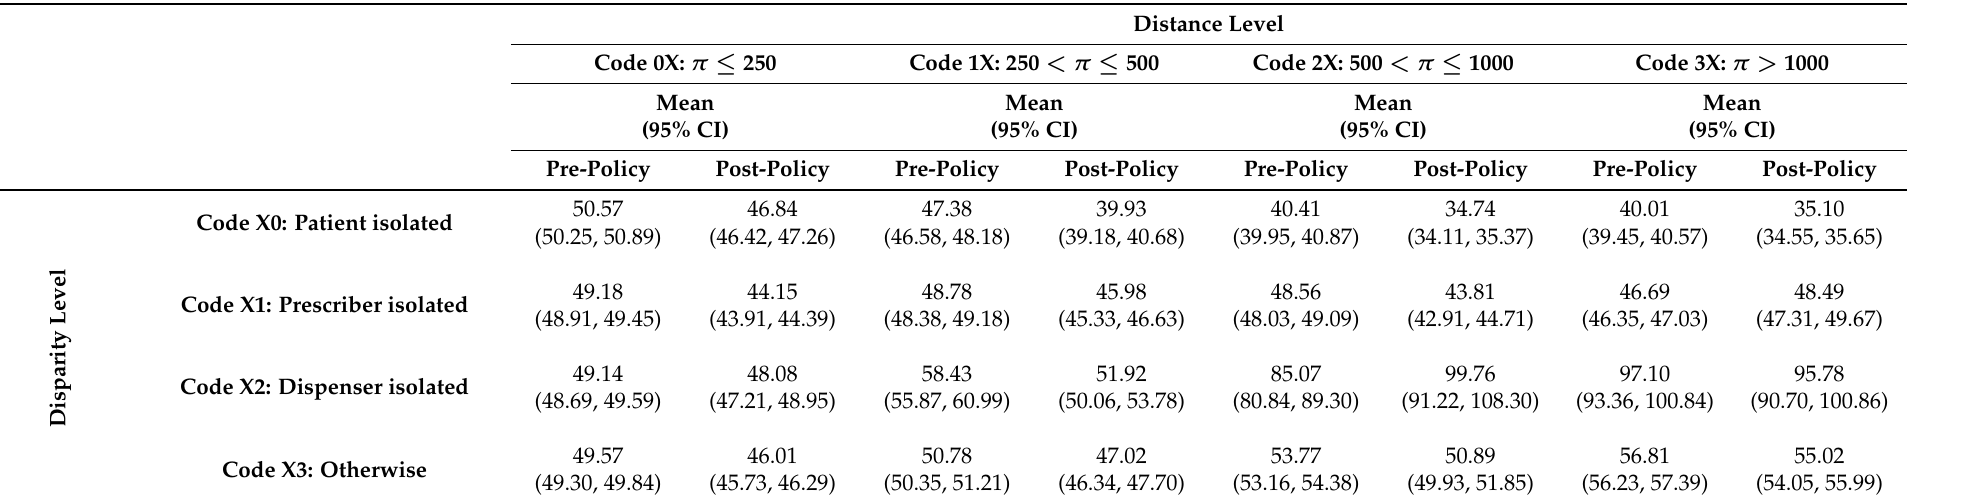
Table 3. The MME per day in each group after and before policy